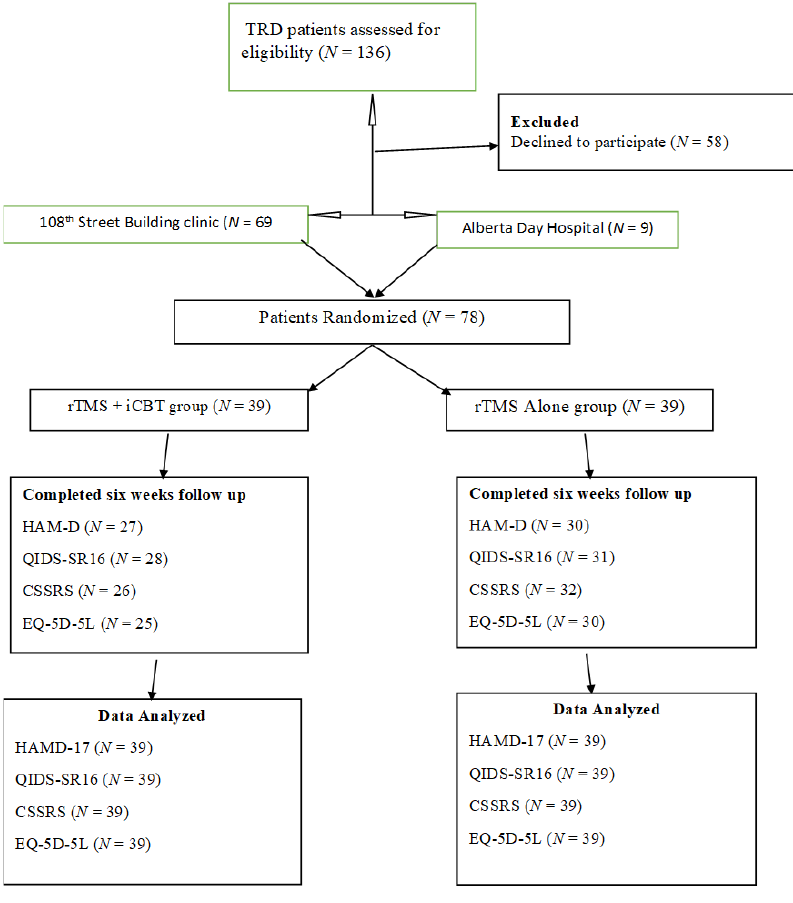
Figure 1. Study flow chart.